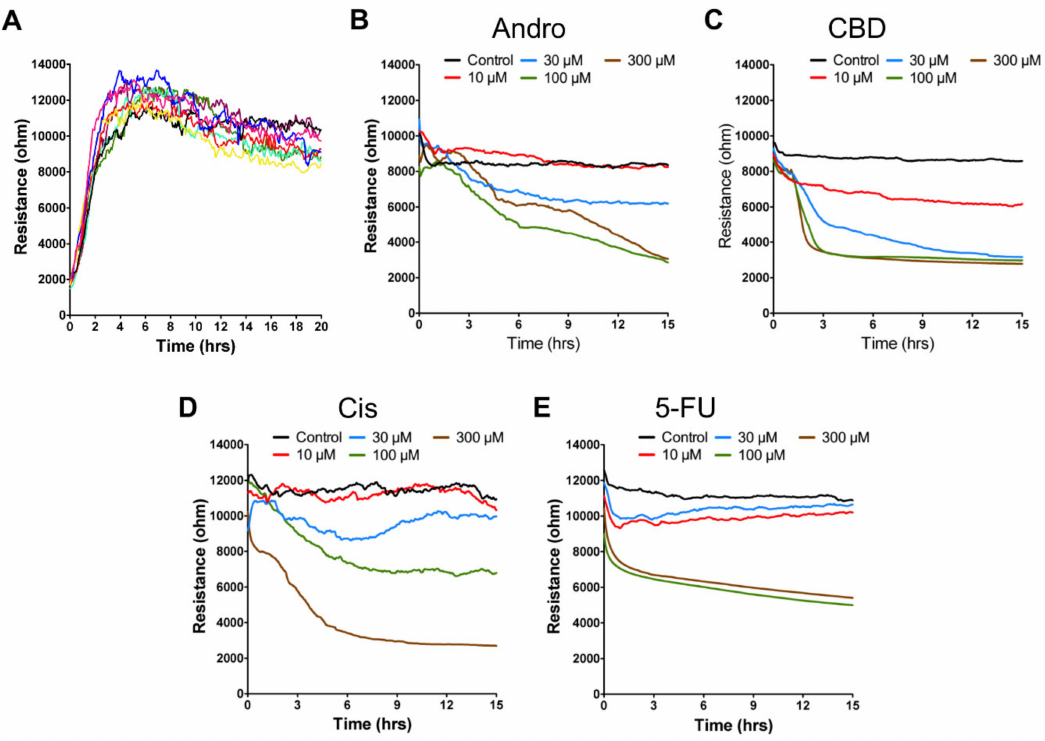
Figure 2. ( A ) Resistance time series of SCC-25 cell attachment and spreading. Each colored curve represents the time course obtained from each of the eight electrode-containing wells. Typical resistance time course of confluent SCC-25 cell layers upon addition of various concentrations of ( B ) andrographolide, ( C ) CBD, ( D ) 5-FU, and ( E ) cisplatin. Three independent ECIS experiments